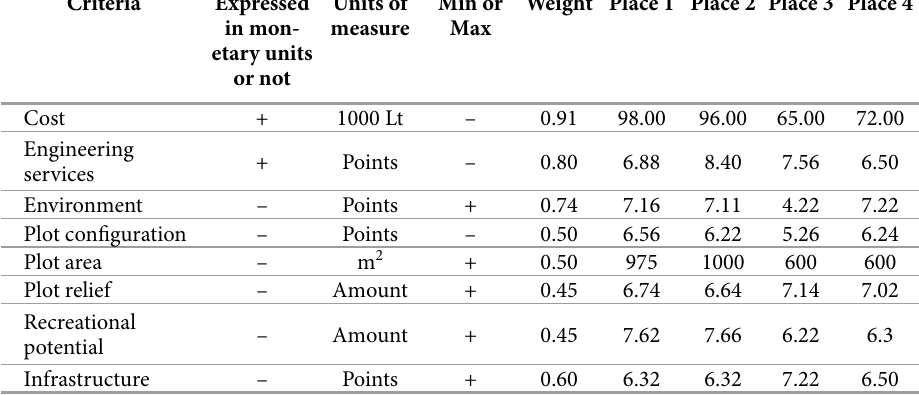
Table 3. Alternatives of multiple criteria evaluation of the plot Criteria